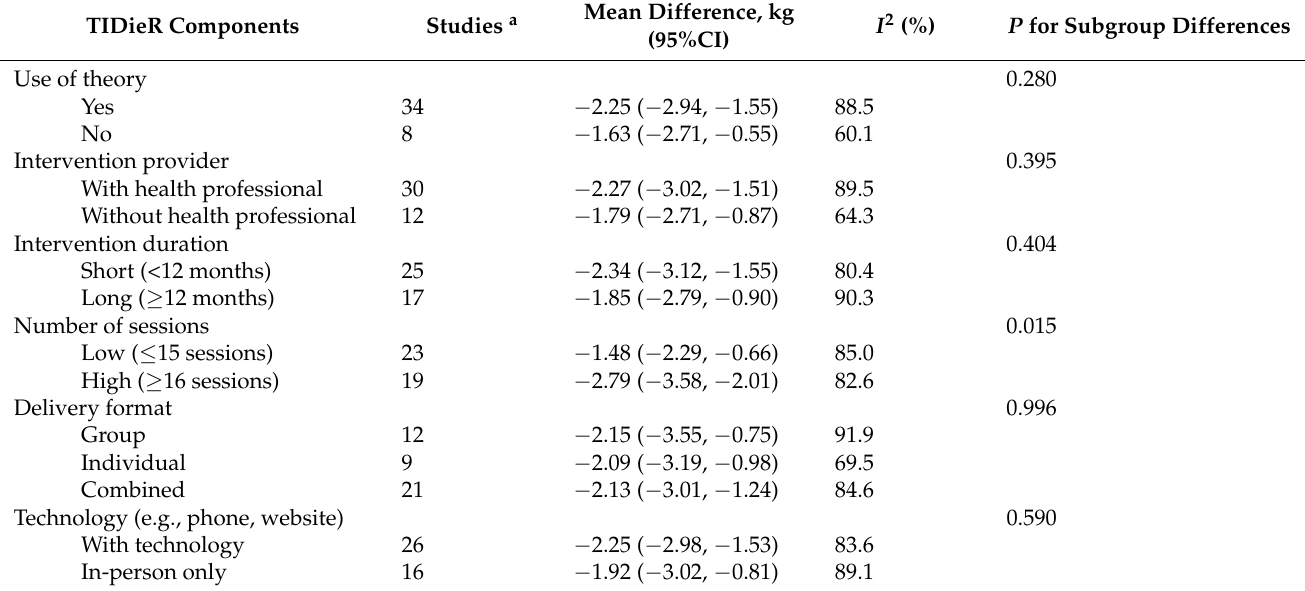
Table 2. Subgroup analyses of lifestyle intervention on body weight by TIDieR